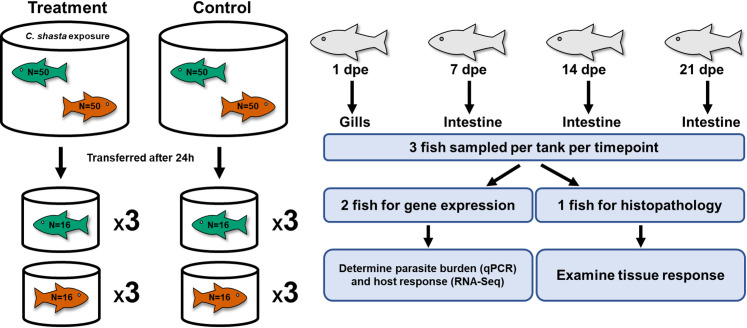
Experimental diagram of the exposure conditions and subsequent sampling of steelhead.Susceptible steelhead (green) and resistant steelhead (orange) were exposed to Ceratonova shasta for 24 hours and then each phenotype was separated and placed into triplicate tanks. Resistant fish had been previously fin-clipped as a means of identification. dpe = days post exposure.